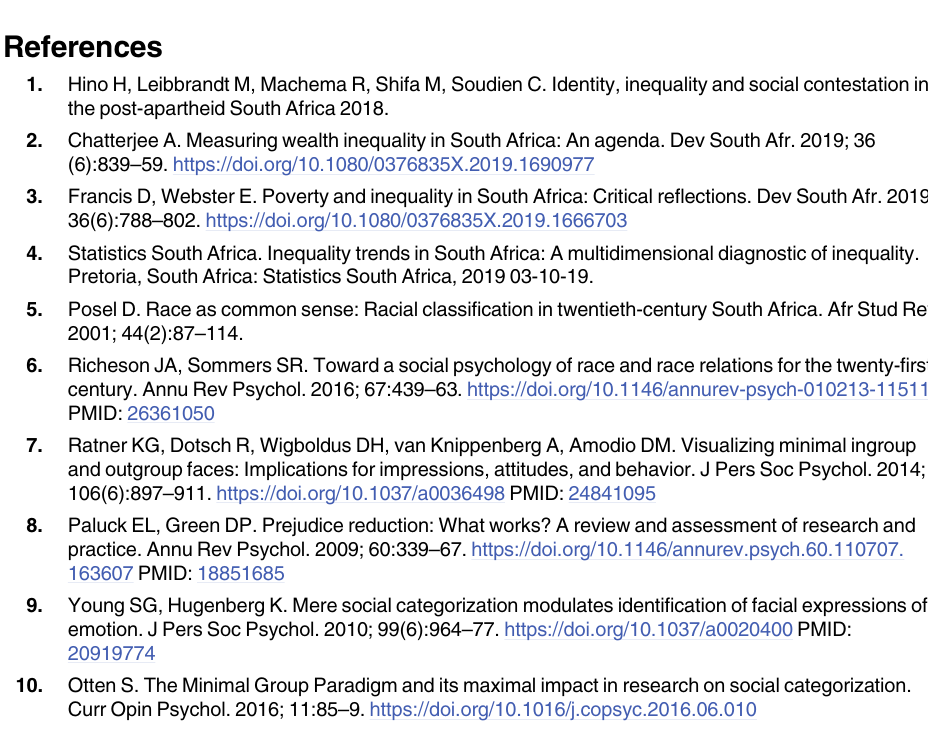
S4 Table. Individual difference measures: Extended results of simultaneous regressions predicting self-reported empathy for different event